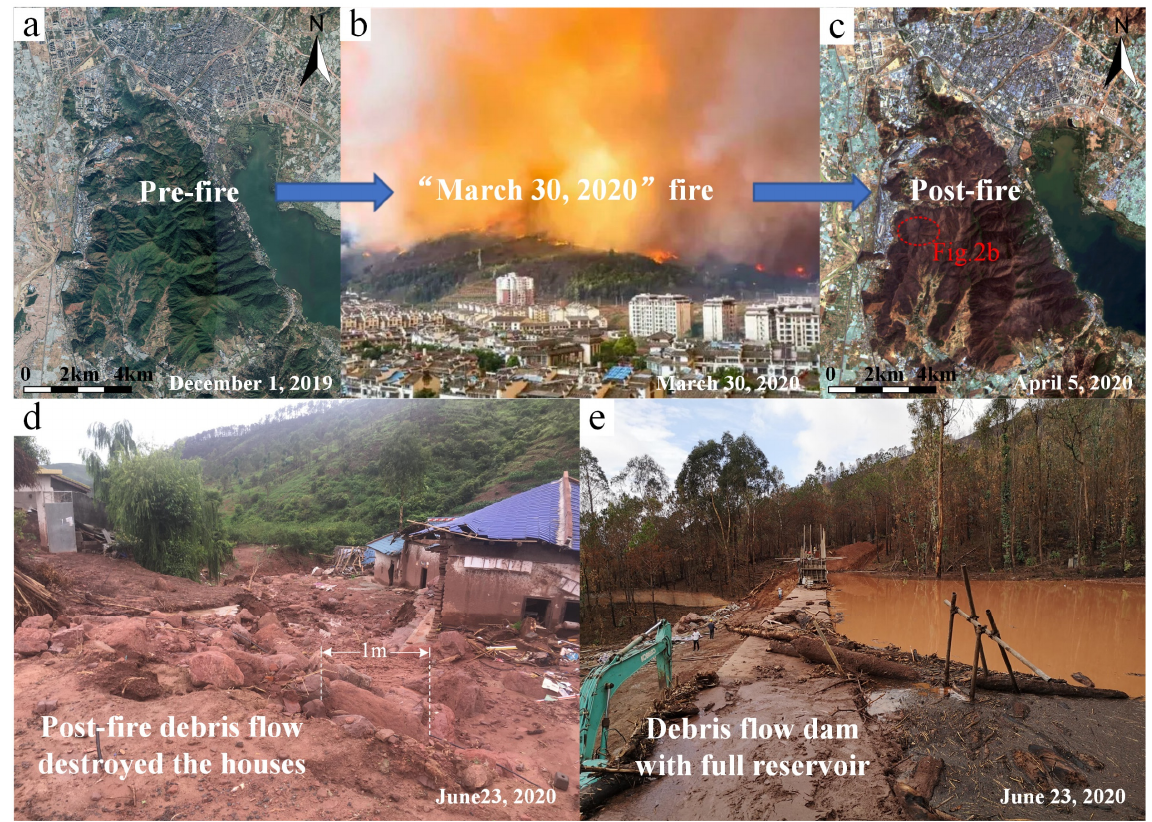
Figure 2. Fire and PFDFs scene photos of “30 March 2020” in Xichang. ( a ) Satellite image of the